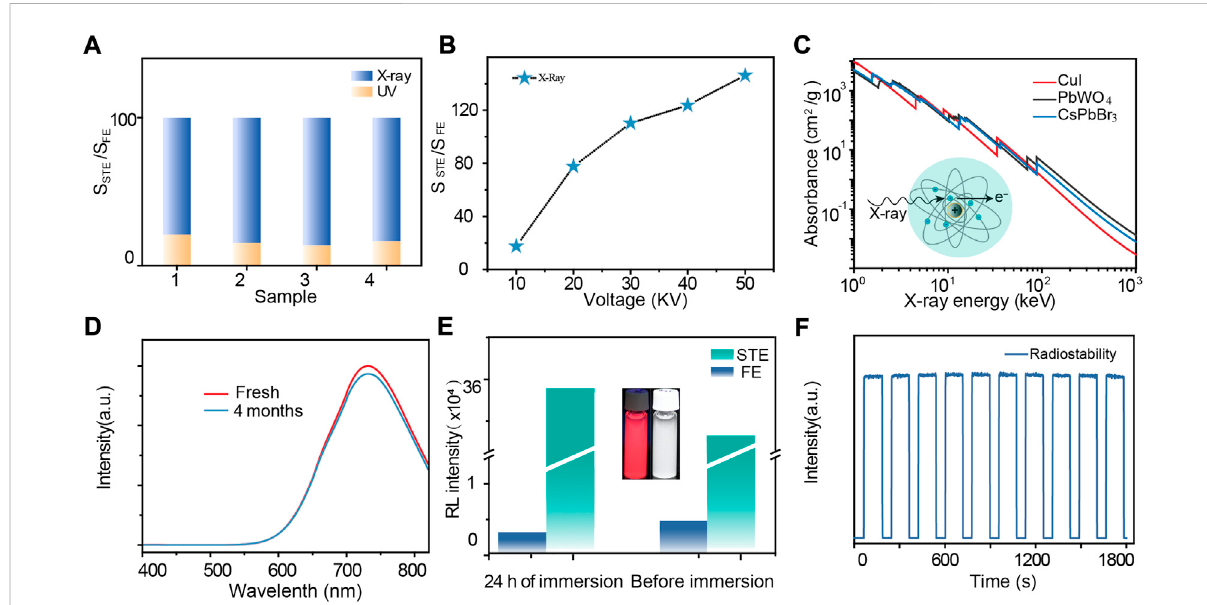
FIGURE 3 (A) Histogram of S STE /S FE under UV excitation and S STE /S FE under X-ray excitation. (B) Absorption spectra of CuI, PbWO 4 and CsPbBr 3 as a function of X-ray energy. Attenuation coef fi cients obtained from reference (Berger et al., 2013). (C) The relation between S STE /S FE as the function of X-raytubevoltage. (D) Comparisonofradioluminescencespectraoffreshand4-month-storedCuImicrocrystals. (E) STEandFEemissionintensities ofCuImicrocrystalsbeforeandafterimmersioninwater. (F) Radiationstabilityofemissionat730 nmunderrepeatedswitchedX-rayirradiation at a dose rate of 278 μ Gy s − 1 .